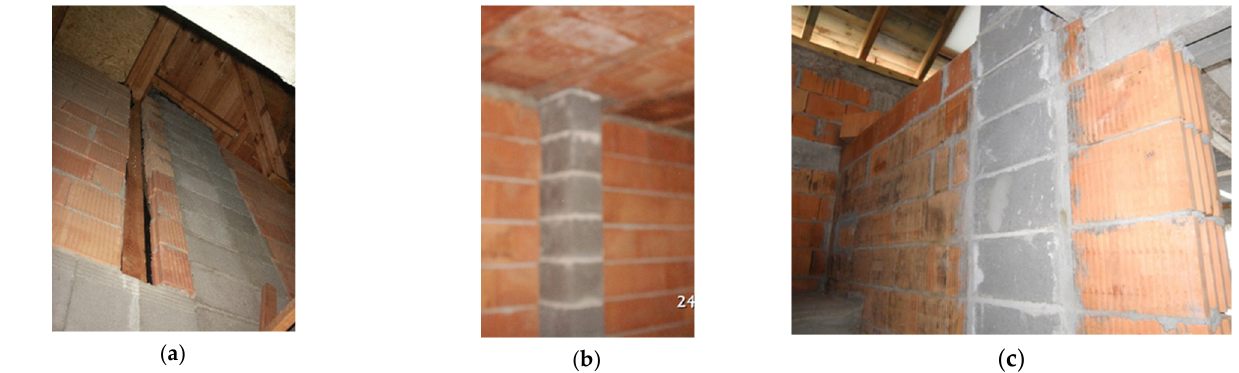
Figure 4. Non-thermally insulated chimney flues: ( a ) in the part above the roof, ( b , c ) in the attic space. These chimneys, both in the attic space and above the roof, do not have layers pro- tecting against excessive heat loss, and they cool down quite quickly. This is one of the